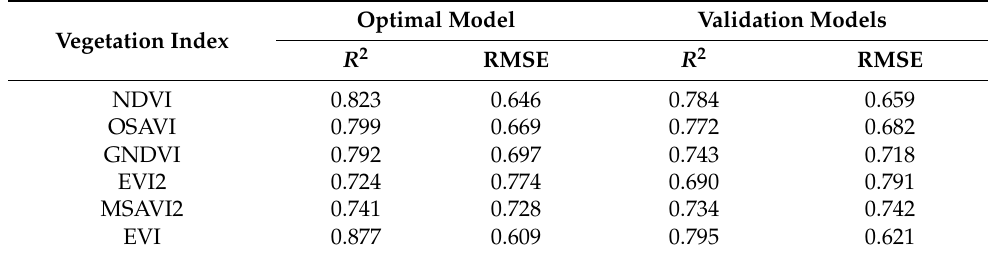
Table 5. The estimation and validation models of leaf area index (LAI) based on vegetation index. Vegetation Index